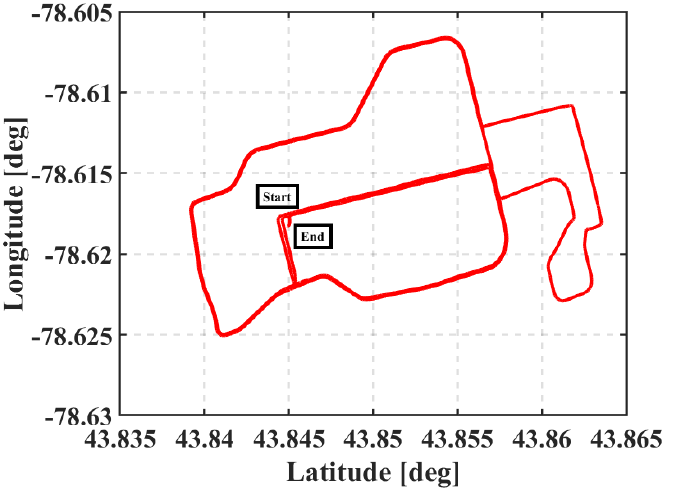
Figure 10. The trajectory of the second vehicular test, Toronto, Ontario, Canada (22 June 2020).